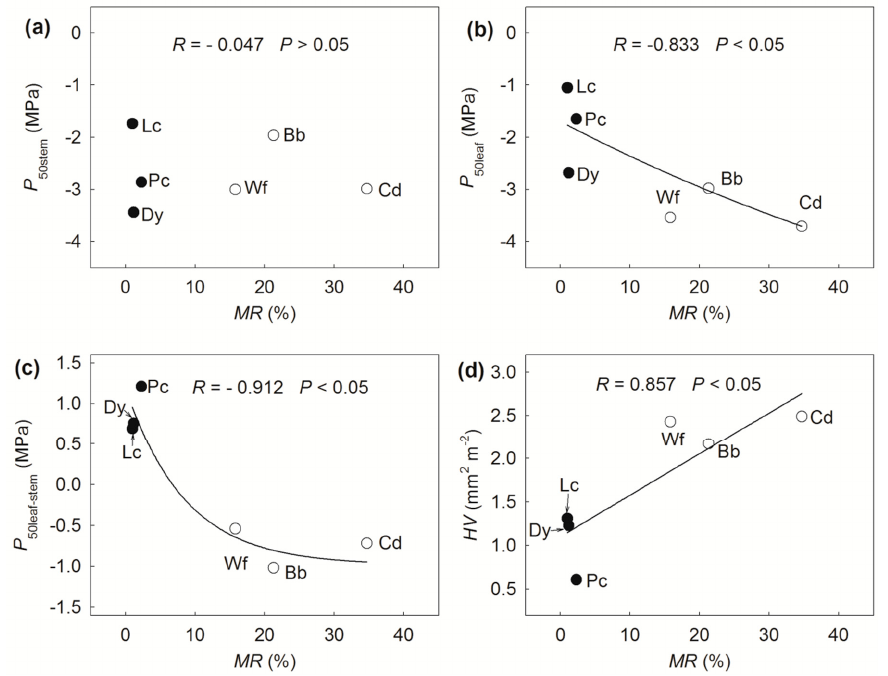
Figure 2. Relationships between mortality rate and hydraulic traits in the six tree species. The abbreviation of functional traits and species codes as shown in Table 1 and Figure 1, respectively. ( a ) P 50stem and MR ; ( b ) P 50leaf and MR ; ( c ) P 50leaf-stem and MR ; ( d ) HV and MR. The hollow and solid circles indicate the NS species and VS species, respectively.